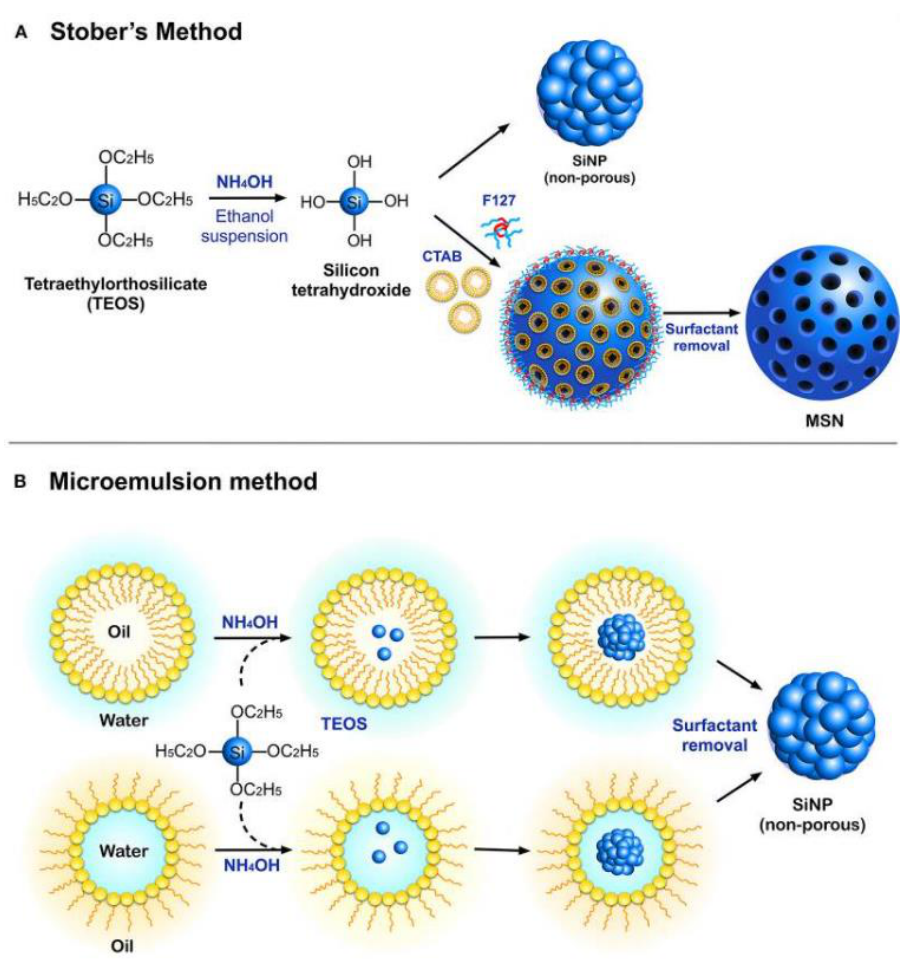
Figure 3. The synthesis of silicon nanoparticles using two different methods. [22]. Used under the Creative Common License.